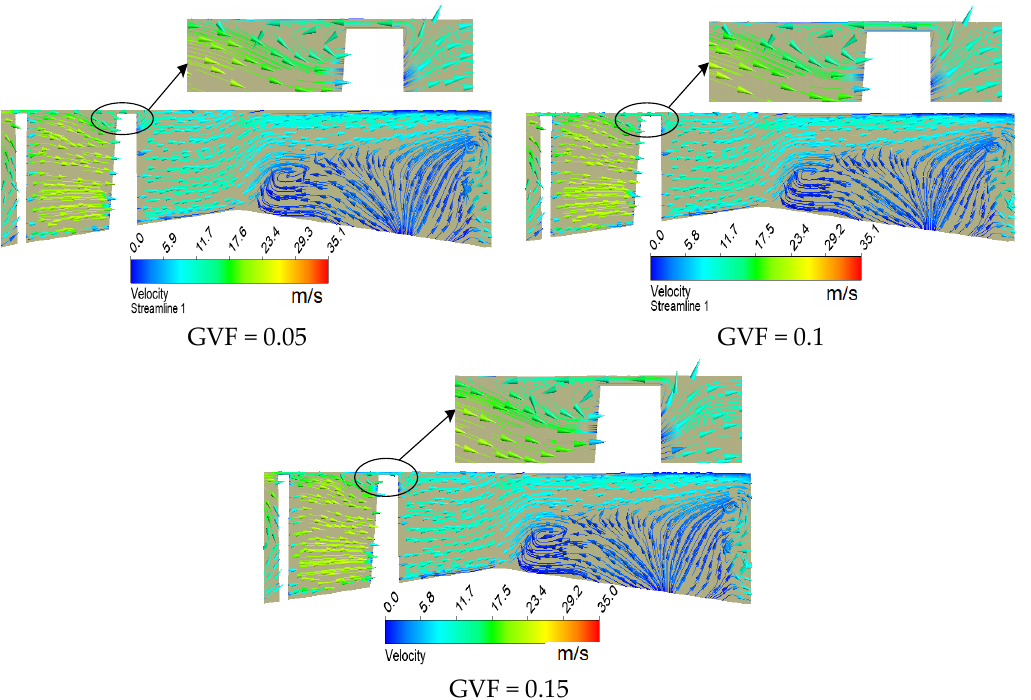
Figure 11. Velocity vector distribution law in the multiphase pump under different GVFs.